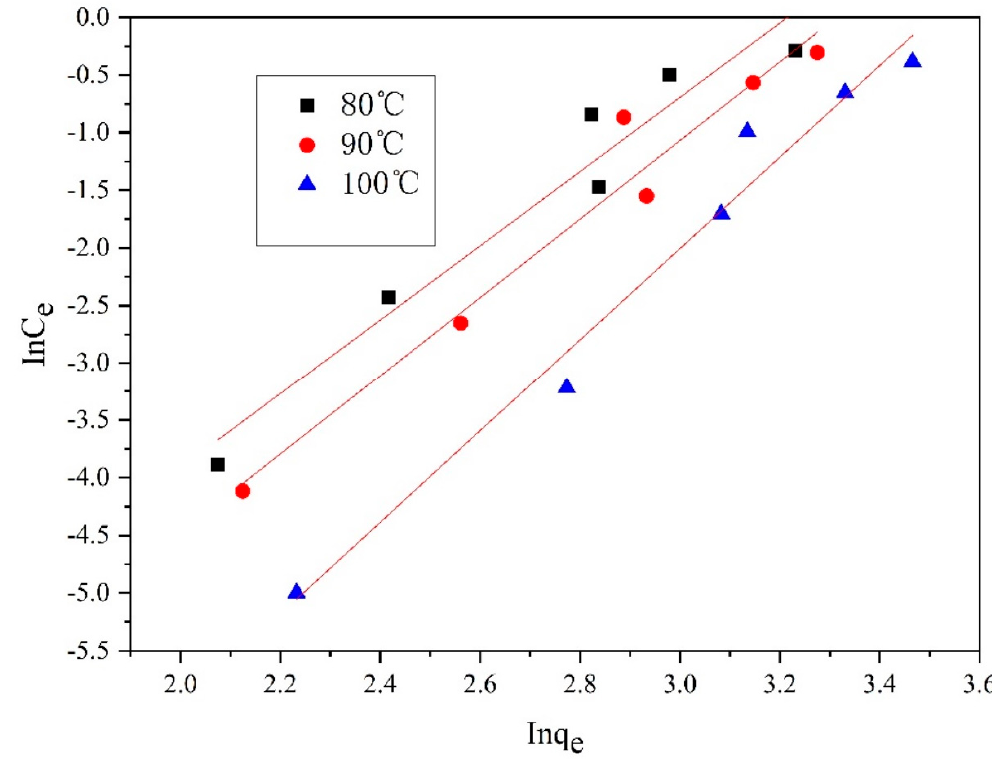
Figure 15. Freundlich model of dyeable spandex dyed with neutral red G.